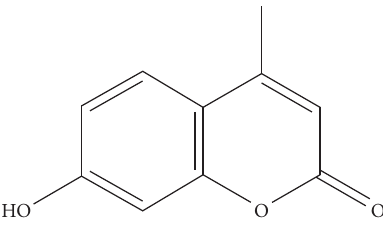
Figure 1: Chemical structure of 4-methylumbelliferone